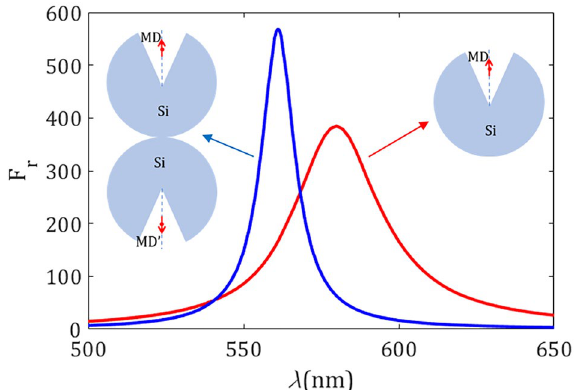
Figure 8. Normalized radiated power F r for the suspended resonator in a vacuum (red line) excited by a MD emitter. Also radiated power for the resonator coupled to its mirror image (blue line) is included. The radius of the resonator, its opening angle, and the dipole distance from the sphere center are R d 10 nm, =